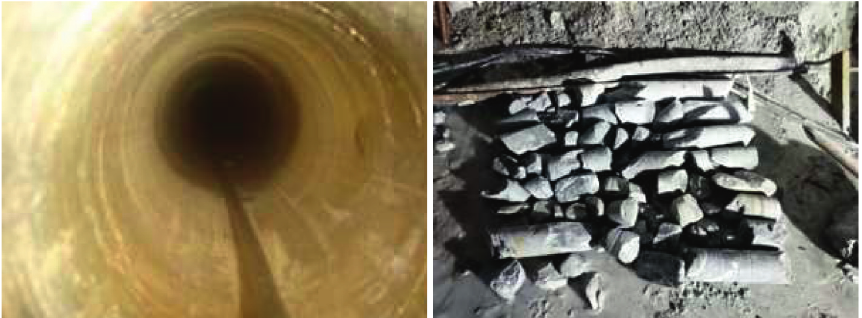
Figure 4: Site drilling and cores